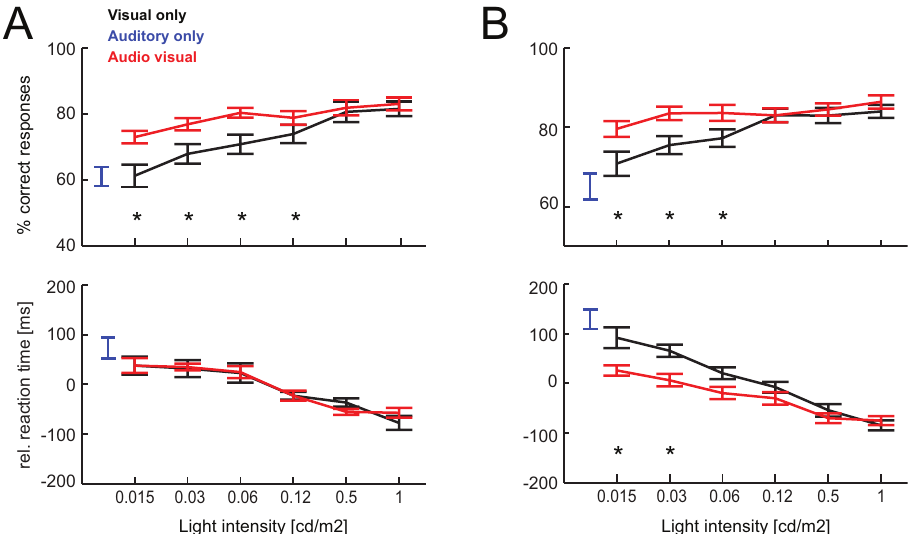
Figure 2. Behavioral performance – main paradigm. Behavioral performance (% correct responses, upper panel) and reaction times (lower panel) for each condition and as function of visual target intensity. Error-bars denote the mean and s.e.m. across animals (n=8). Reaction times were normalized by subtracting each animals mean reaction time (computed across all conditions). Stars indicate statistical significance (ANOVA p , 0.05). The data in A) were obtained after 10 days of training, those in B) after 25 days. Note that reaction times (e.g. for the visual condition) in B appear slower compared to A because of the normalization. Actual values for the visual conditions were comparable while those for the audio-visual conditions were shortened in B (c.f. data presented in the main